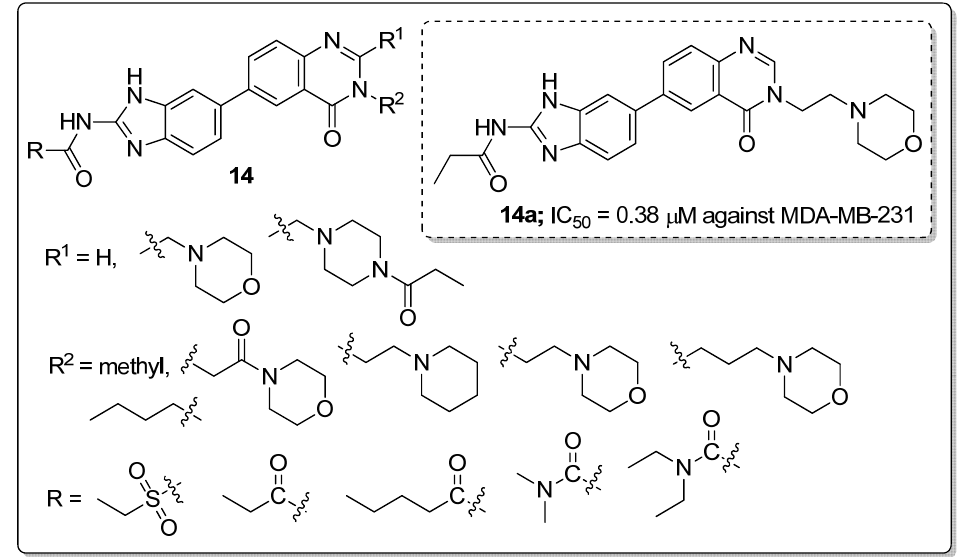
Figure 17. Cytotoxic activity of the most active benzoimidazole ‐ quinazolinone hybrid 14a .